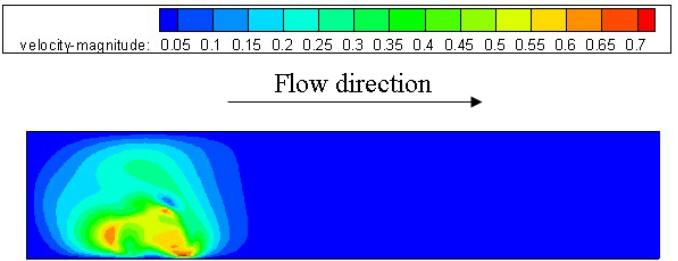
Figure 11. Velocity contour in the channel with constant contact angle of 145° ( t = 1 ms).